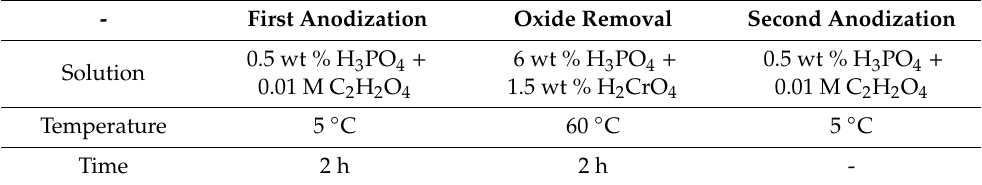
Table 1. The experimental parameters of two-step anodic oxidation.